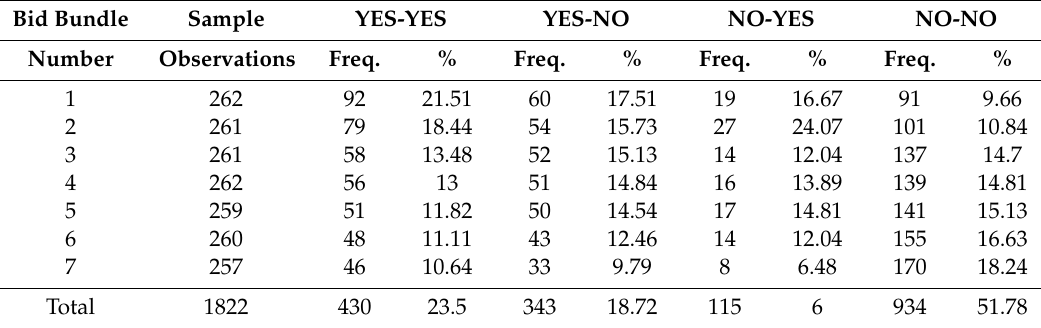
Table 3. Distribution of responses to the seven bid